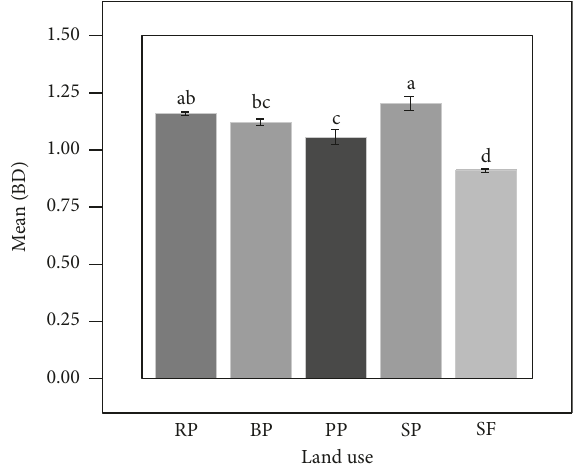
Figure 1: Effect of land-use change on soil bulk density (BD).